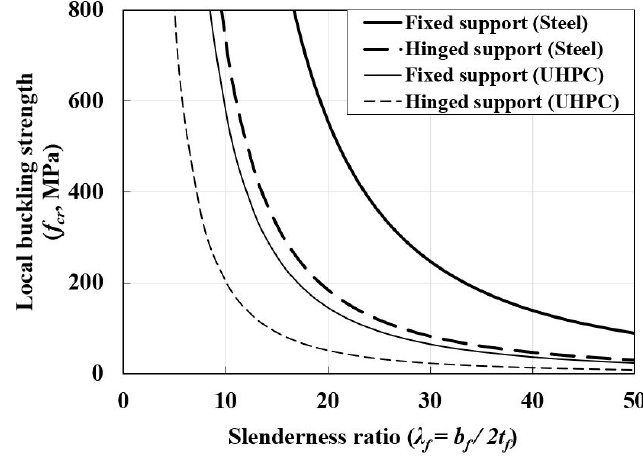
Figure 7. Comparison of elastic local buckling strength of UHPC and steel flanges.